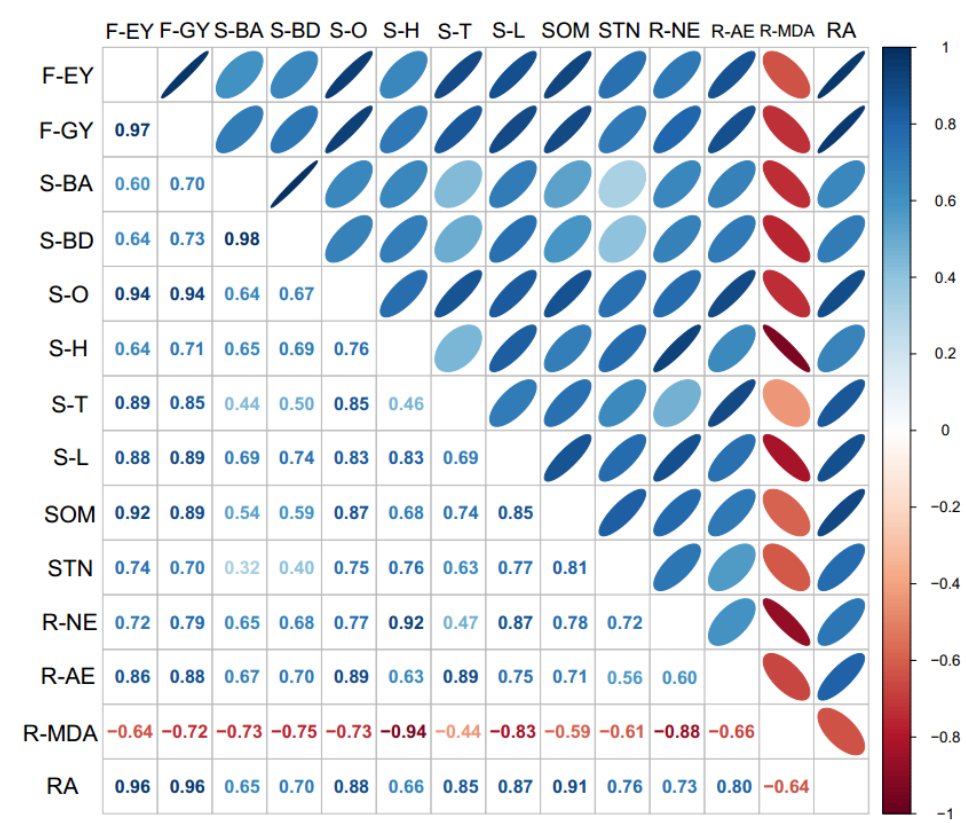
Figure 6. Spearman correlation analysis among rhizosphere soil characteristics, root activity, and yields based on 2 years of fresh waxy maize. F − EY and F − GY represent fresh ear yield and fresh